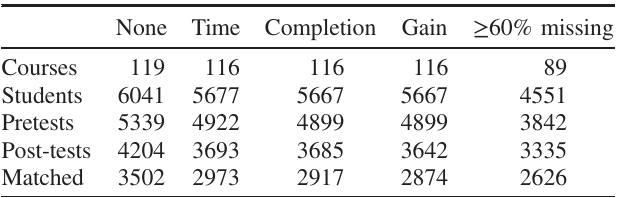
TABLE I. Data after each filter was